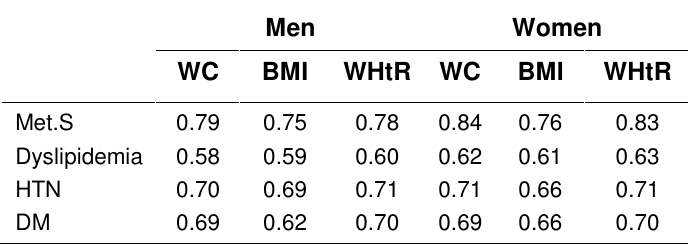
Area under the ROC Curves for Anthropometric Measures and Cardiovascular Disease Risk Factors Men Women WC BMI WHtR WC BMI